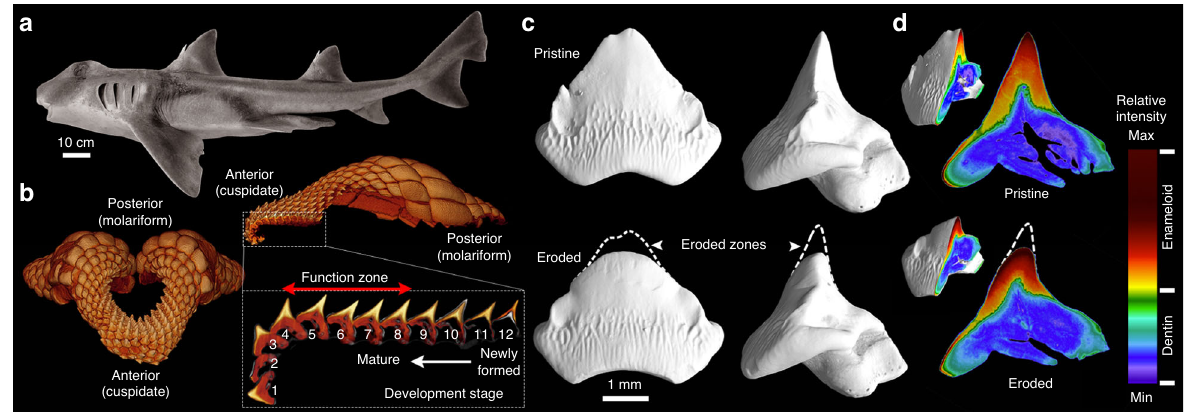
Fig. 1 Anterior cuspidate teeth of the Port Jackson shark. a Photograph of an adult male Port Jackson shark ( H. portusjacksoni ). b X-ray microtomography image of the upper jaw tooth array showing the arrangement of the cuspidate and molariform teeth, at the anterior and posterior edges of the tooth array, respectively. The bottom inset image shows a single “ fi le ” of the cuspidate teeth, and the development from newly formed, to functional to post-functional teeth. c High-resolution X-ray microtomography demonstrating the change in tooth cusp morphology that occurs as teeth pass through the functional zone (i.e., from rows 8 – 4). d Virtual sections of the same pre-functional and post-functional teeth, illustrating erosion occurs only in the enameloid layer. In addition to the sharp transition in relative density between enameloid and dentin, a gradation in density is also present within the enameloid